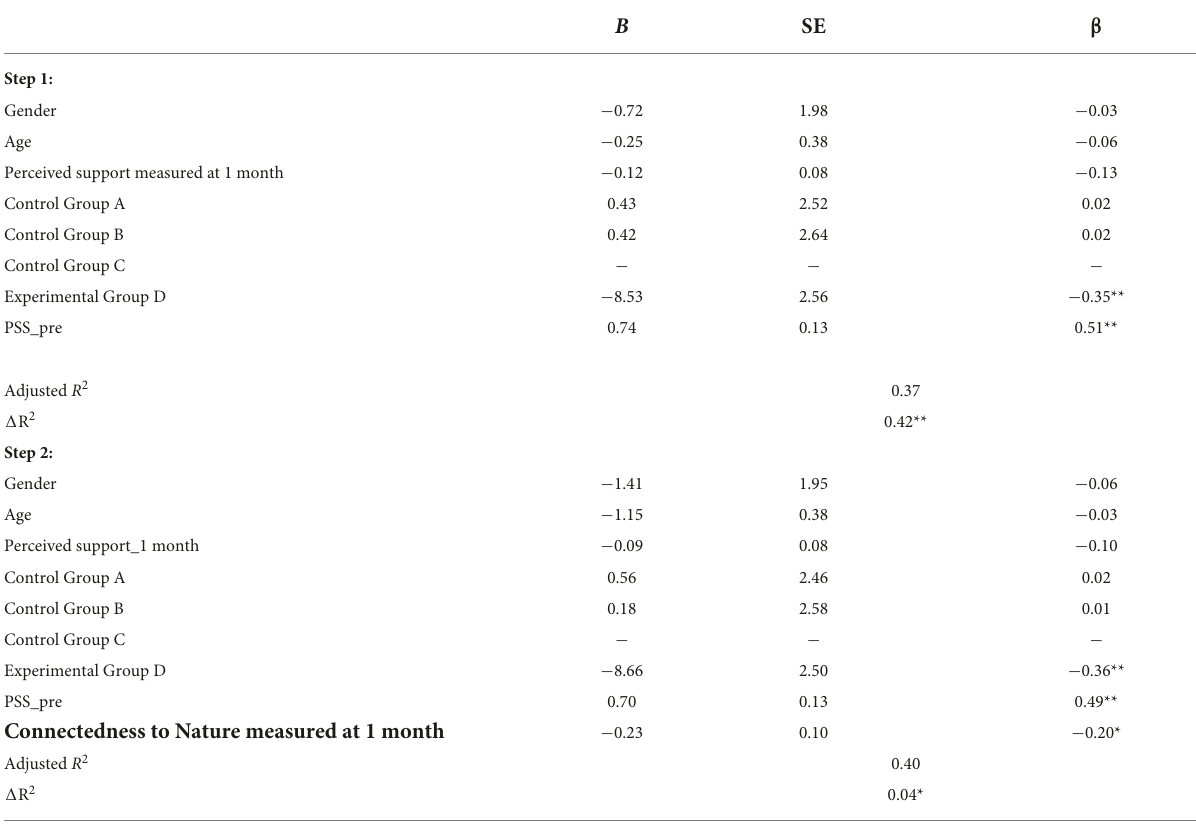
TABLE 7 Summary of Hierarchical Multiple Regression result on Perceived Stress Scale-14 ( N =